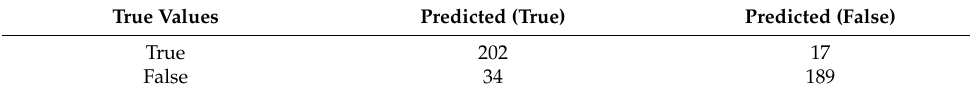
Table 9. ANN Confusion Matrix.